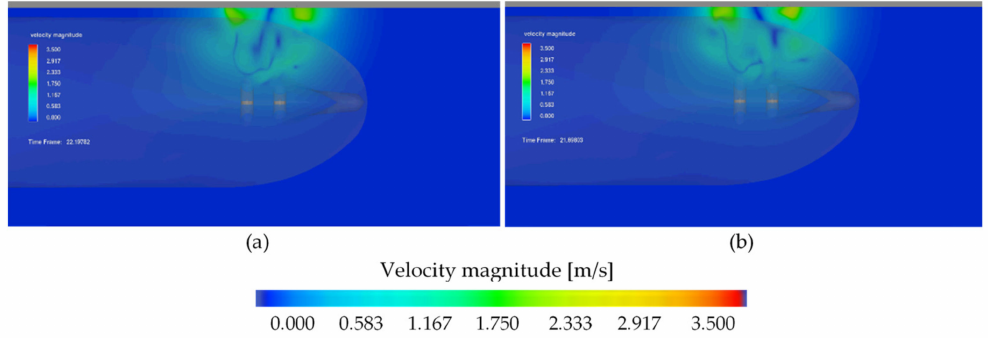
Figure 10. Velocity field on the seabed—results of CFD simulation for Ferry 2: ( a ) both the bow thrusters operating with 105 kN thrust each during the period of time of 10 s, maximum velocity 2.4 m/s; ( b ) both the bow thrusters operating with 130 kN thrust each during the period of time of 10 s, maximum velocity 3.0